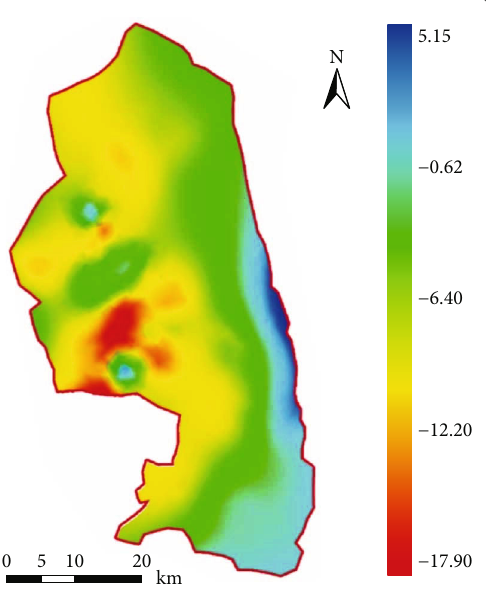
Figure 6: Map of the groundwater level